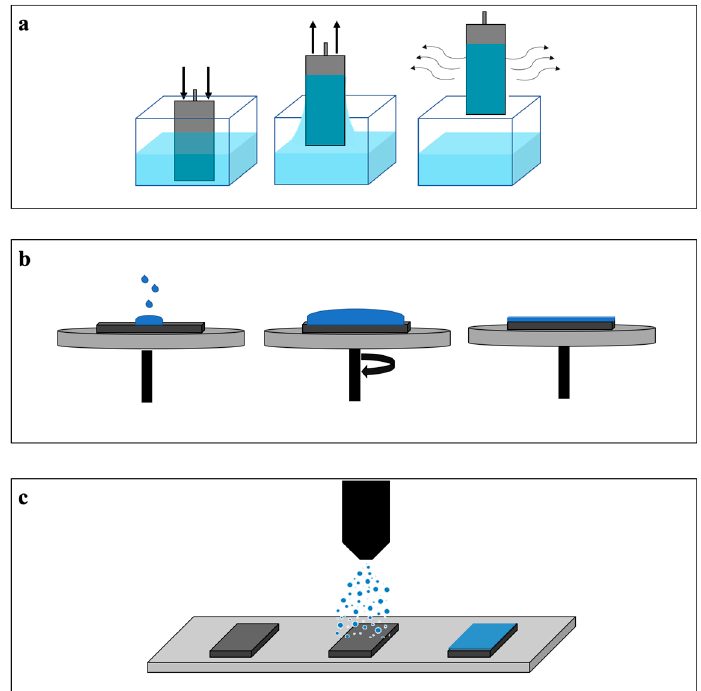
Figure 2. Schematic representation of: ( a ) dip coating; ( b ) spin coating; and ( c ) spray coating.